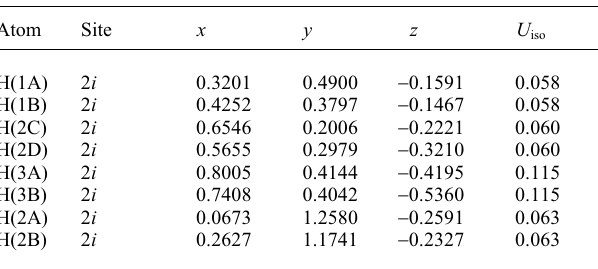
Table 2. Atomic coordinates and displacement parameters (in Å 2 )